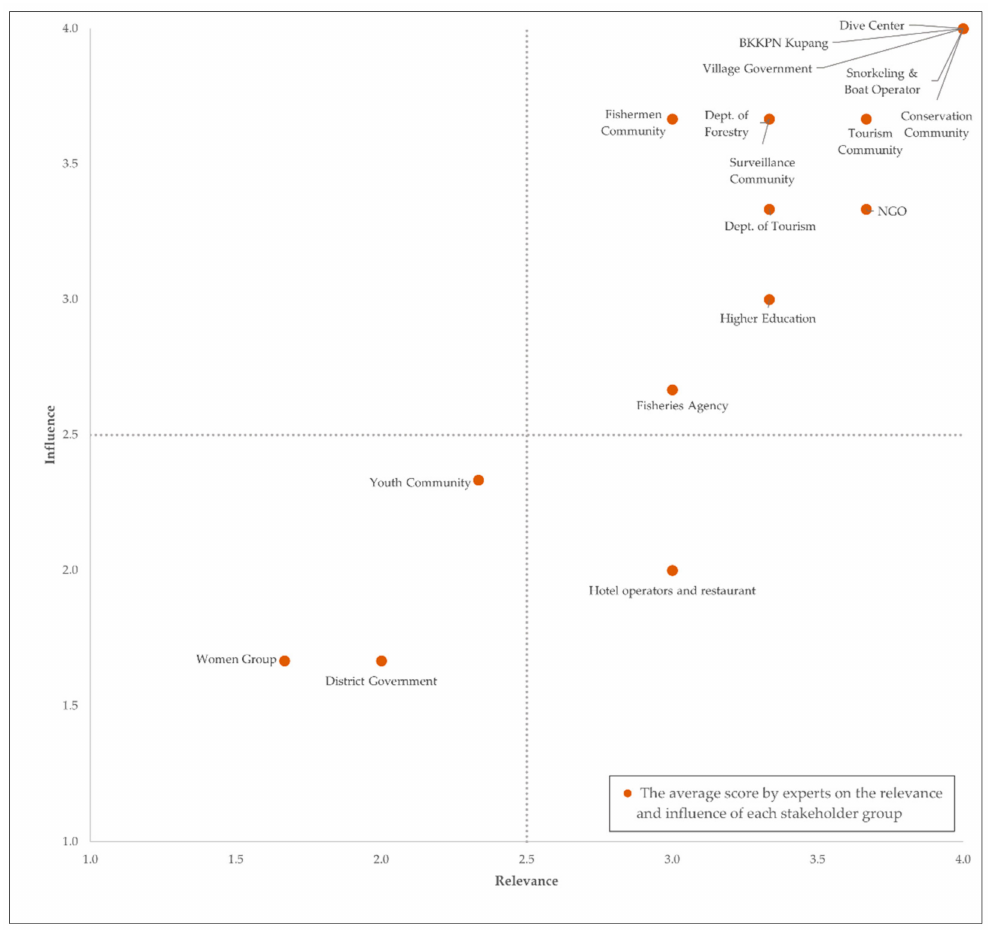
Figure 3. Assessment result of the local stakeholder groups of GMMTP. The “key stakeholders” are indicated by high influence (Y Axis) and high relevance (X Axis) values (highlighted in the upper-right